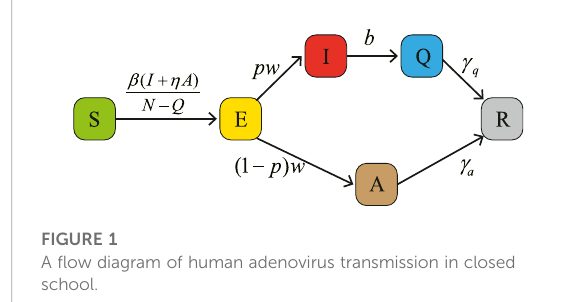
FIGURE 1 A fl ow diagram of human adenovirus transmission in closed